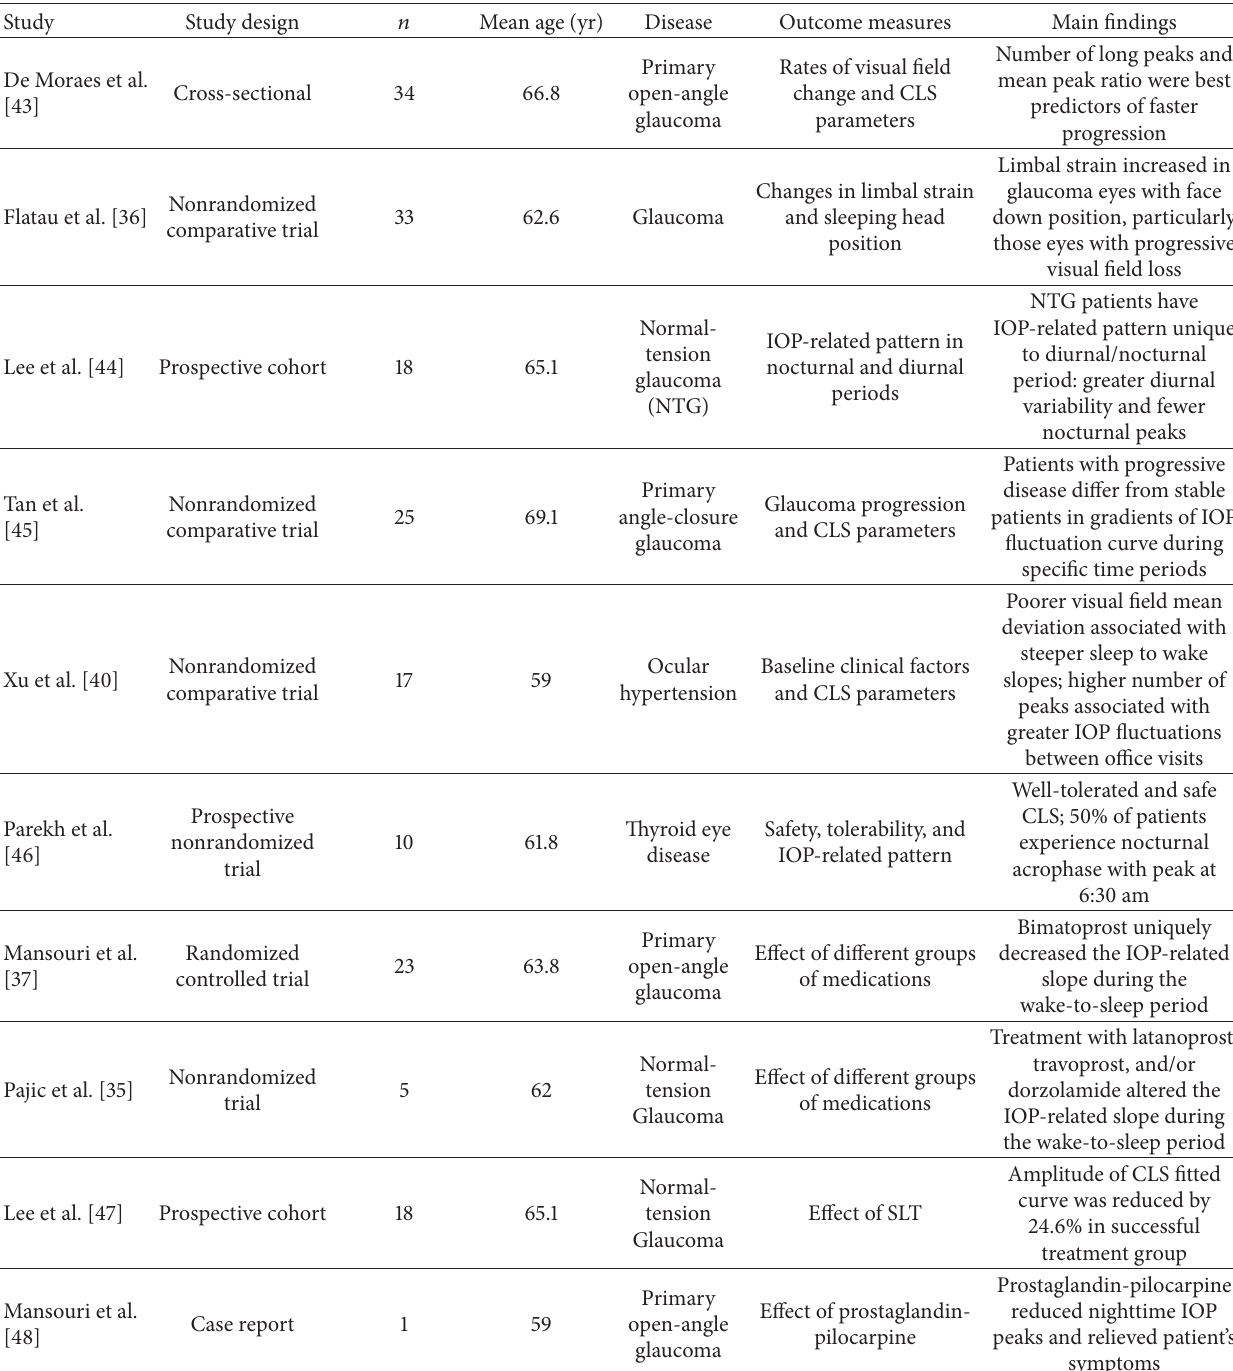
Table 1: Summary of studies using the CLS in the discovery of risk factors, characterization of circadian rhythm, and investigation of effects of IOP-lowering